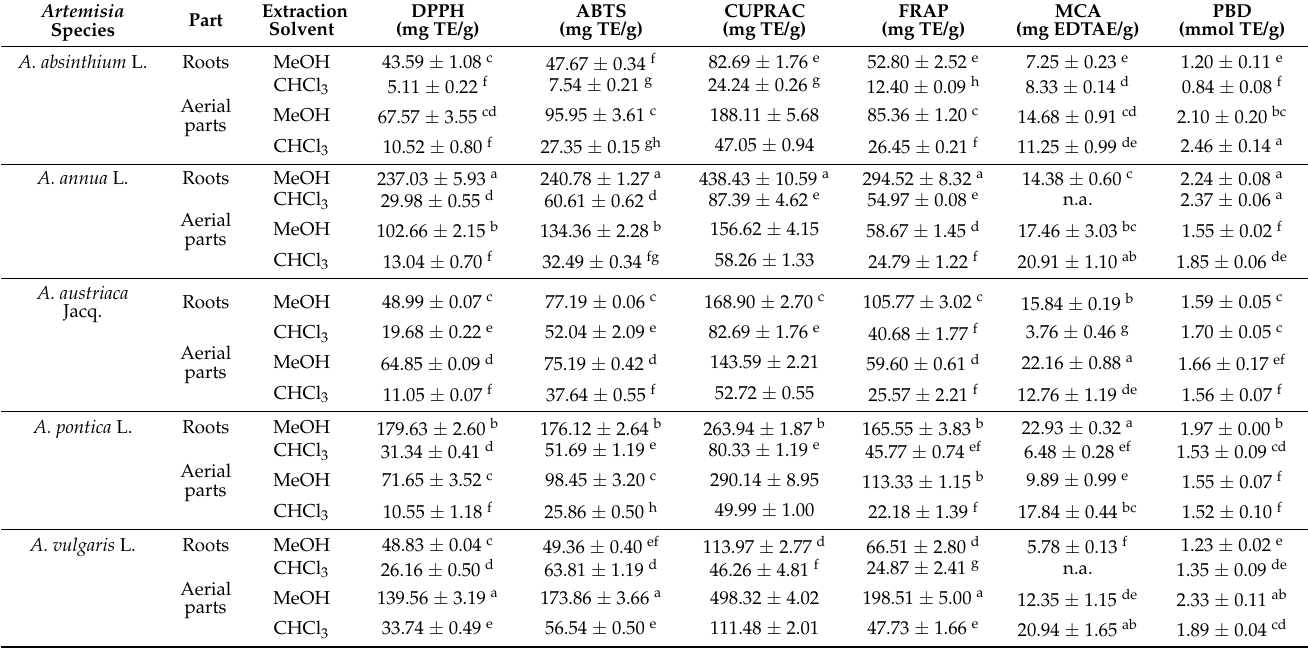
Table 3. Antioxidant activity of Artemisia spp.